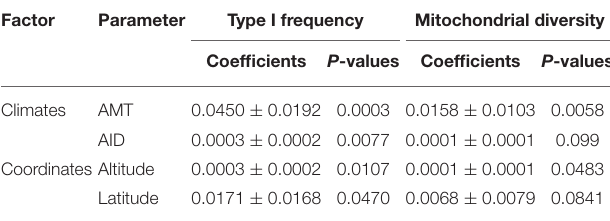
TABLE 4 | Multiple regression analysis of the contribution of local climatic conditions or geographic positions to the mitochondrial genome in the P. infestans populations from